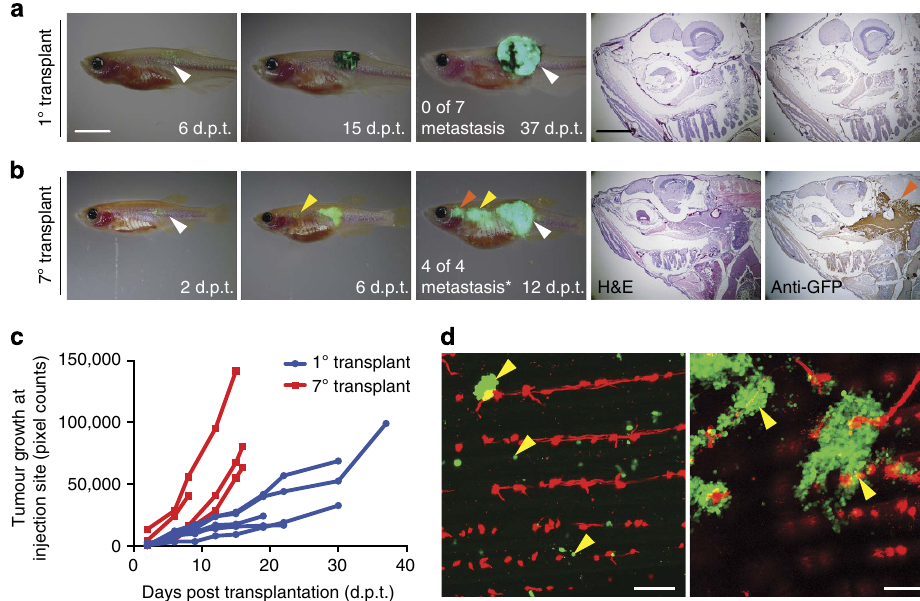
Figure 6 | Assessing metastatic potential and the functional consequences of tumour evolution in melanoma. ( a , b ) Serial imaging of engrafted GFP- labelled melanoma implanted into adult rag2 E450fs (capser) mutant fish. The 1 (cid:2) transplant was pigmented ( a ), whereas the 7 (cid:2) transplanted melanoma had lost pigmentation ( b ). Number of animals with metastatic growth is noted (* P ¼ 0.003, Fisher’s exact test comparing 1 (cid:2) and 7 (cid:2) transplant). White arrow indicates the site of injection. Yellow and red arrows denote sites of distal metastases. Histological staining (H&E and anti-GFP) of distal metastasis is shown in the right panels. ( c ) Quantification of tumour growth at the site of initial engraftment over time. ( d ) Confocal imaging of micro-metastatic lesions found adjacent to the tail vasculature of flk1:mCherry; rag2 E450fs (casper) -recipient fish engrafted with 7 (cid:2) transplant melanoma. Yellow arrows denote micro- metastatic lesions. Scale bars equal 5mm for whole animal images in a , b , 2mm for histology shown in a , b and 200 m m in d